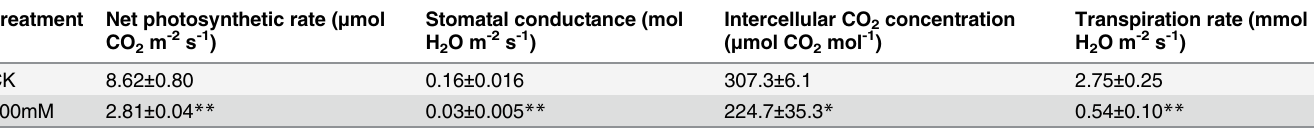
Table 1. Effects of salt stress on leaf gas exchange in Brassica napus .